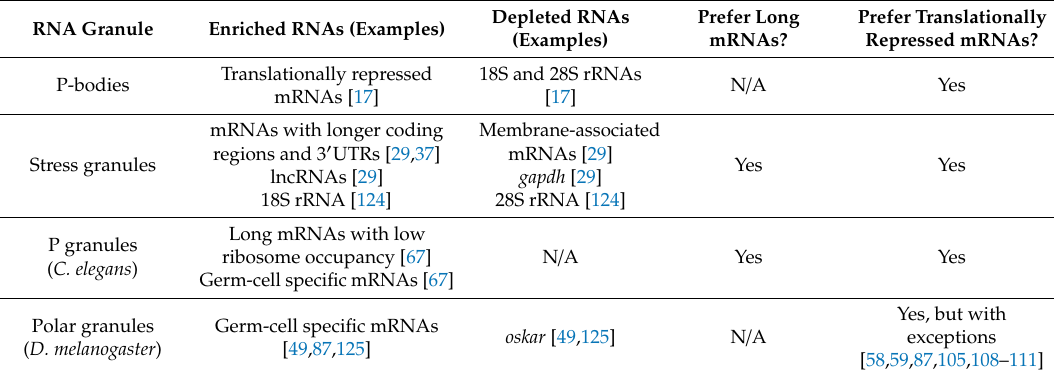
Table 1. Characteristics of RNAs enriched in RNA